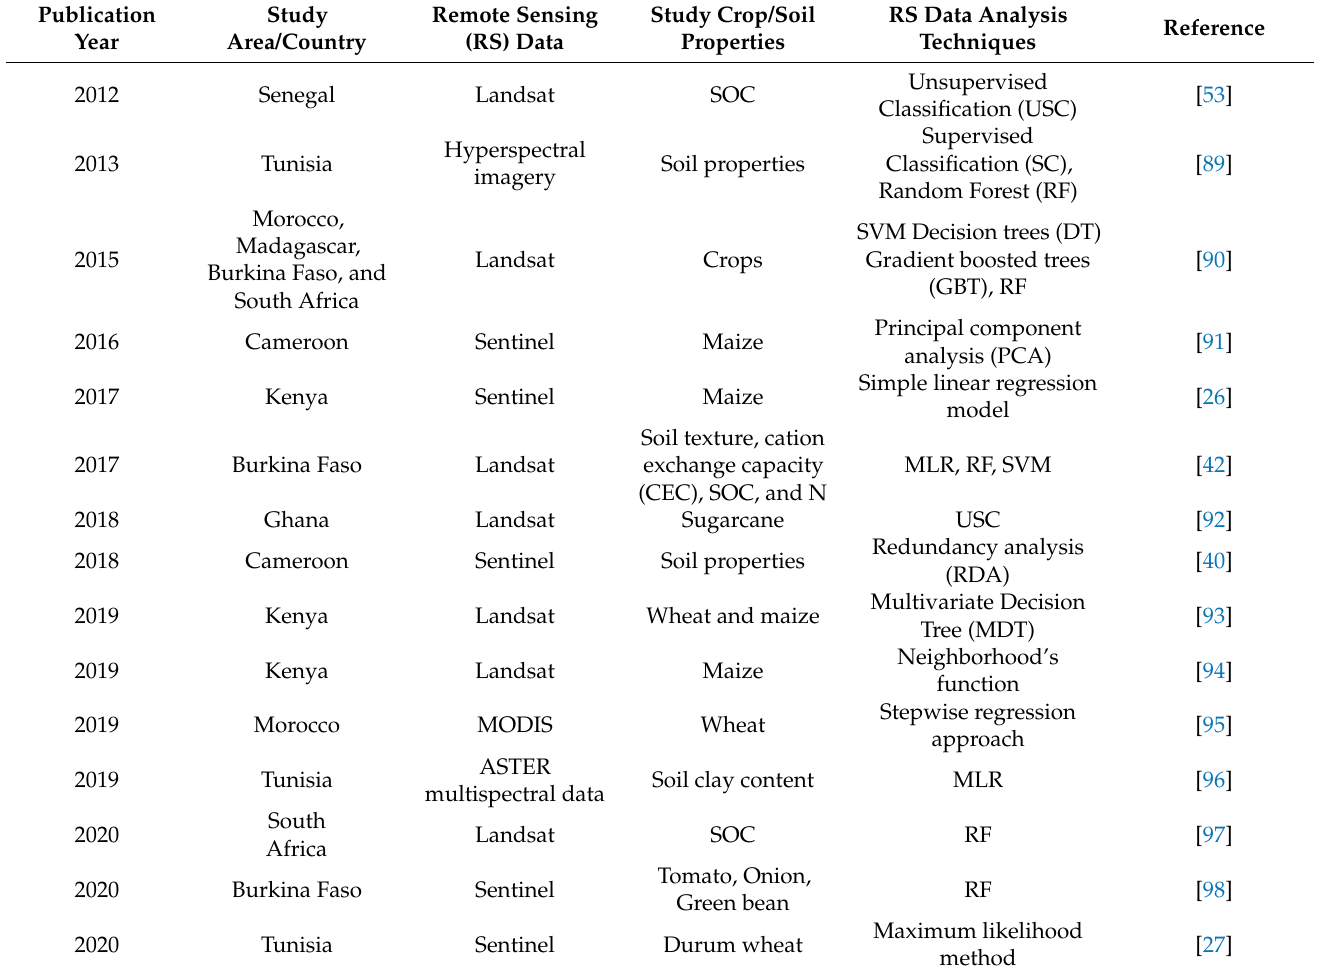
Table 3. Summary of papers related to remote sensing used in the study, sorted by publication